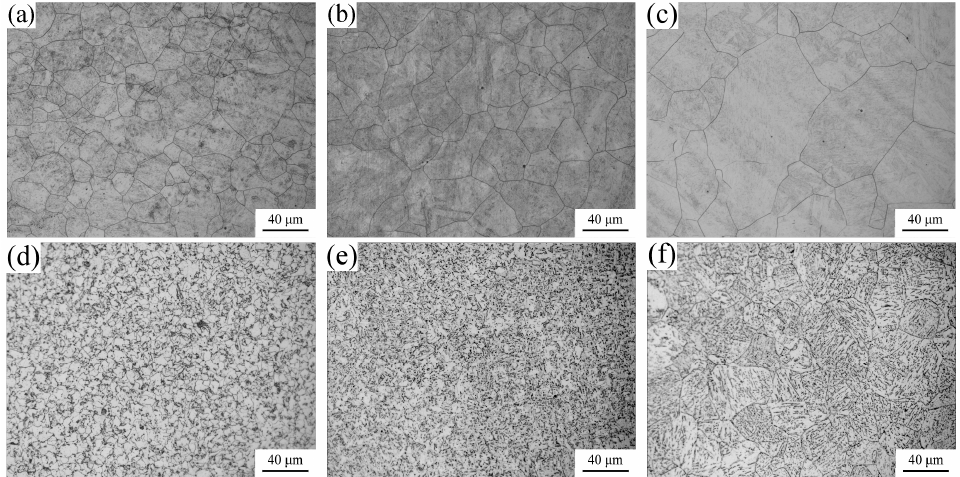
Figure 3. Optical images of prior austenite grain boundary ( a – c ) and microstructures ( d – f ) at different reheating temperatures: ( a , d ) 990 °C; ( b , e ) 1030 °C; ( c , f ) 1080 °C.